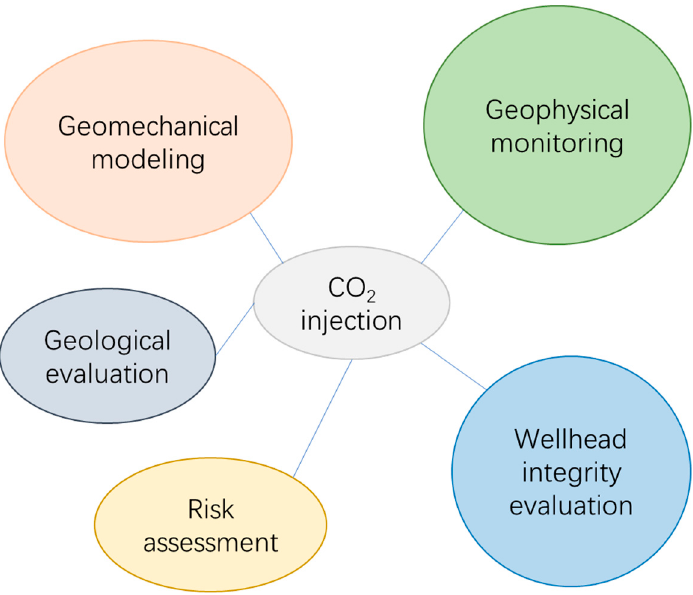
Figure 3. Technical tools applied in CCUS projects (modified from Whittaker S et al., 2011 [27]).